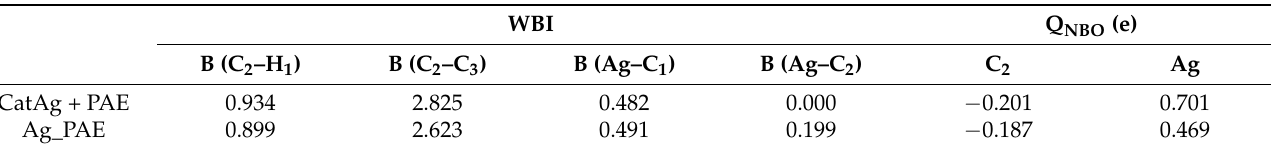
Table 1. The Wiberg bond indices (WBIs) and natural charges (Q NBO ) for the addition reaction between catalyst CatAg and PAE .